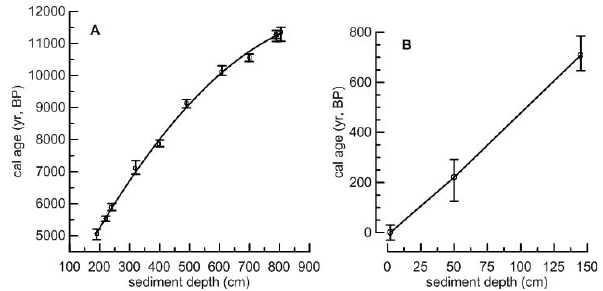
Fig. 2. Calendar age versus GeoB8332-1 sediment depth. Open cir- cles, vertical bars, and lines indicate 14 C-based age model control points, uncertainty in the age model control points (2 σ ), and the final age model that is based on polynomial (A) and linear fits (B)